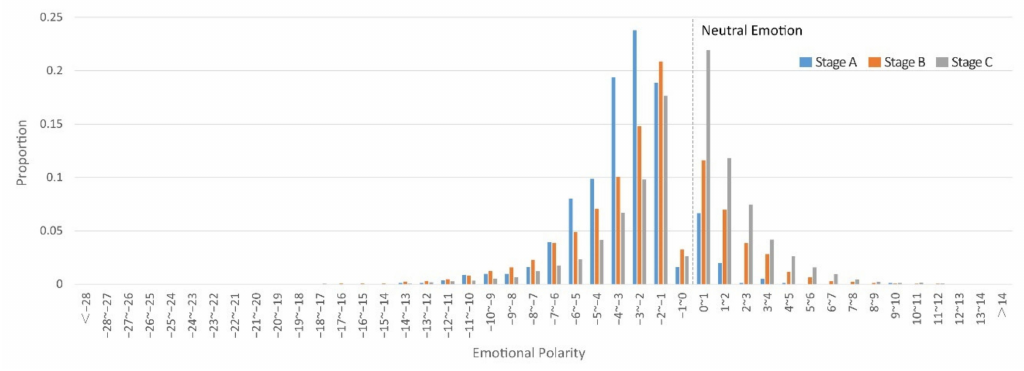
Figure 5. Distribution of sentimental polarity for the three stages.